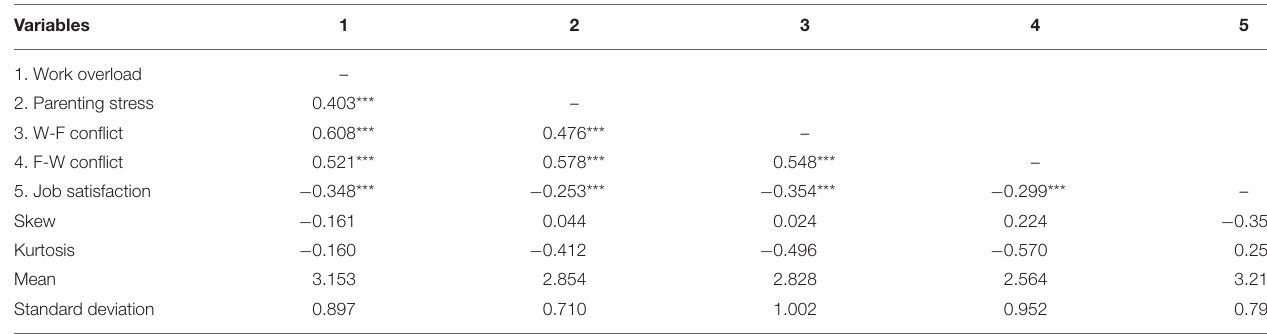
TABLE 1 | Correlations and descriptive statistics for the main study variables.